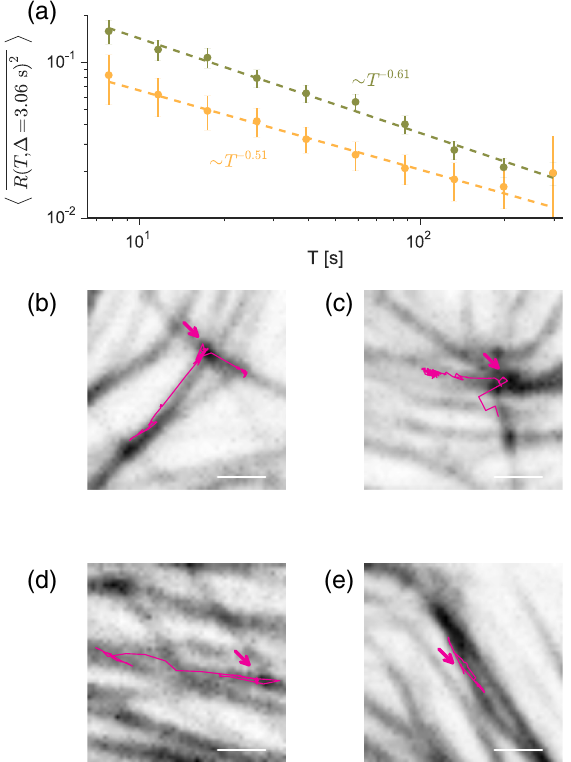
FIG. 6. Experimental trajectories show cycling. (a) Trajectories are divided into two groups according to the total fluorescence intensity of the motor. The group with higher fluorescence intensity (green) shows a larger aging exponent than the low- fluorescence group (yellow). (b) – (e) Representative trajectories of individual myosin II minifilaments overlayed onto the actin network. Arrows denote cycling events. Trajectories are obtained from myosin II minifilaments on an actin network bundled with fimbrin. Scale bar is 1 . 1 μ m, trajectories shown are imaged at 1.5 s intervals; see Supplemental Material for details [30]. Single- particle trajectories are obtained using the Python-based imple- mentation of the Crocker-Grier algorithm TRACKPY